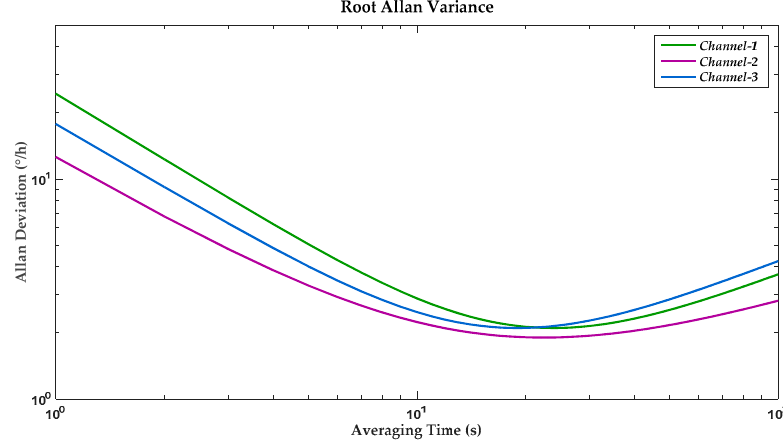
Figure 21. Measured root Allan variance of triple channels at room temperature.